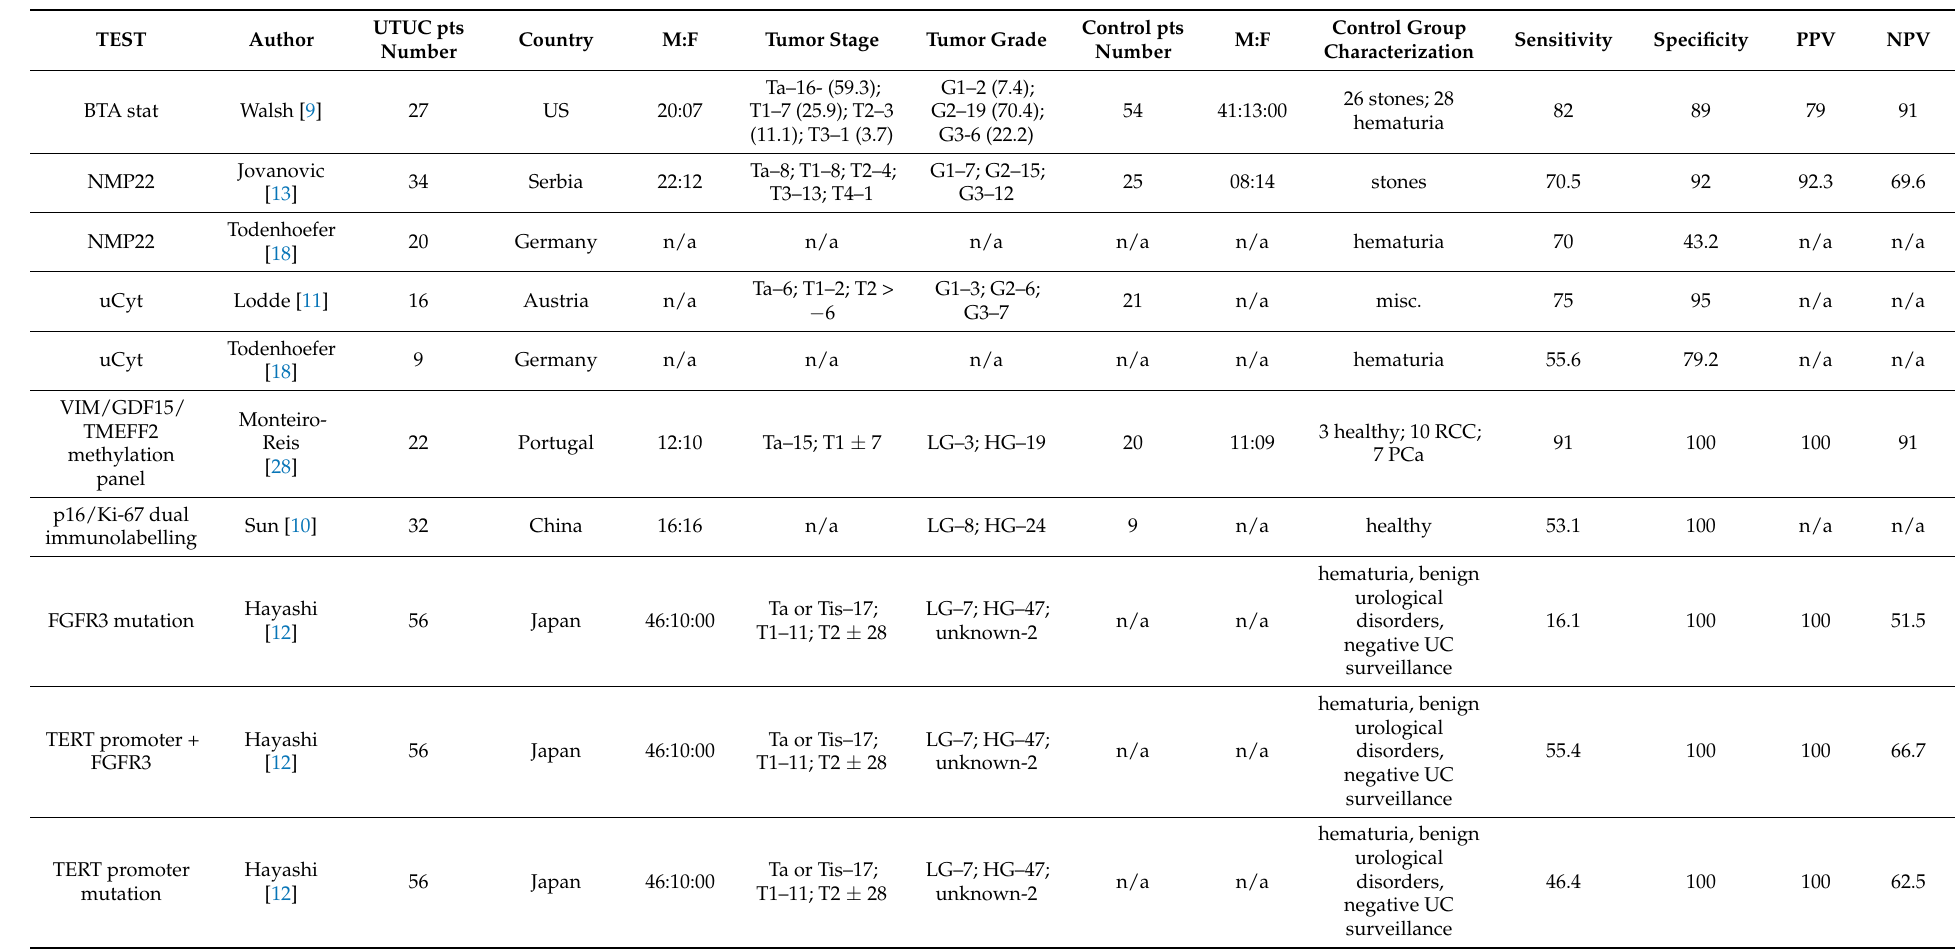
Table 3. The performance of other urinary tests in the diagnosis of